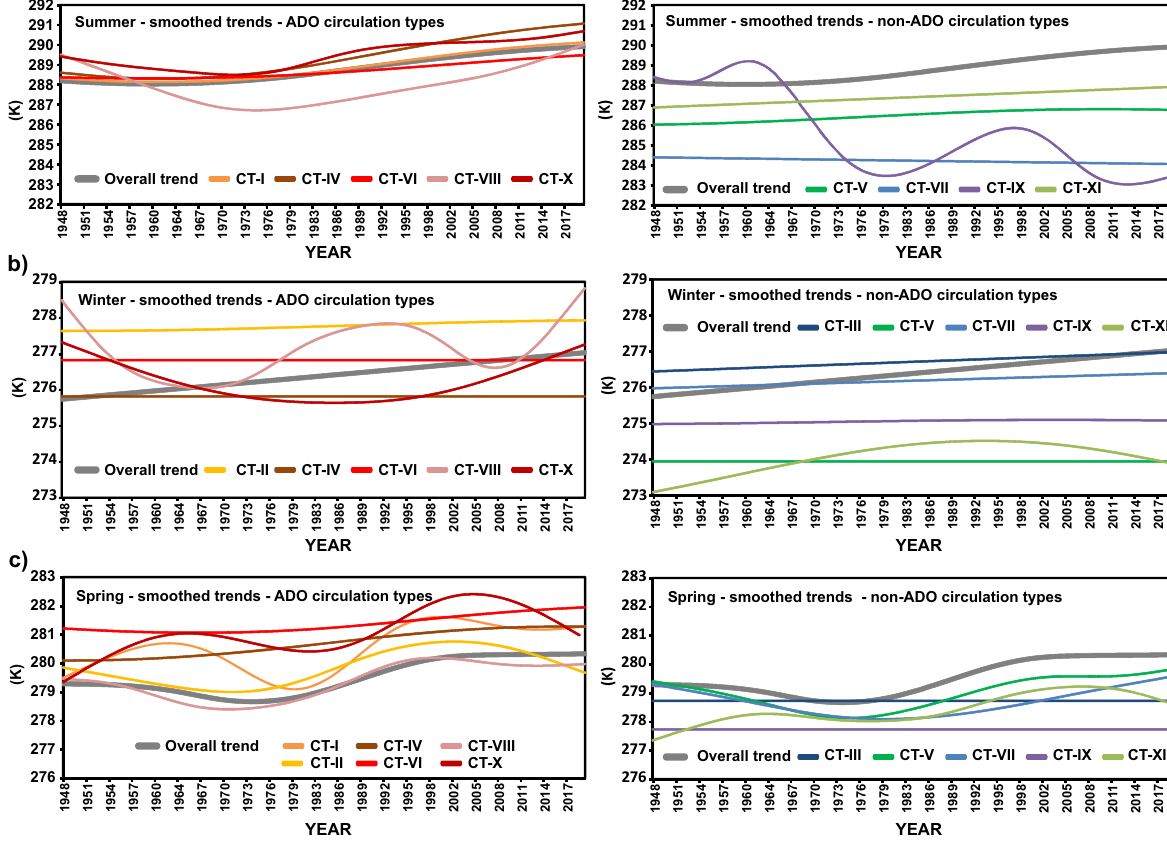
Fig. 8 Time evolution of temperature at 850 hPa over the IP and the BI domain over 1948 – 2020. Smoothed trend of the monthly mean levels of temperature at 850 hPa averaged over the Iberian Peninsula and the Balearic Islands in the period 1948 – 2020 (overall trend) and during the occurrence of the 8 circulation types (CT) obtained from the circulation classi fi cation process in summer ( a ), winter ( b ) and spring ( c